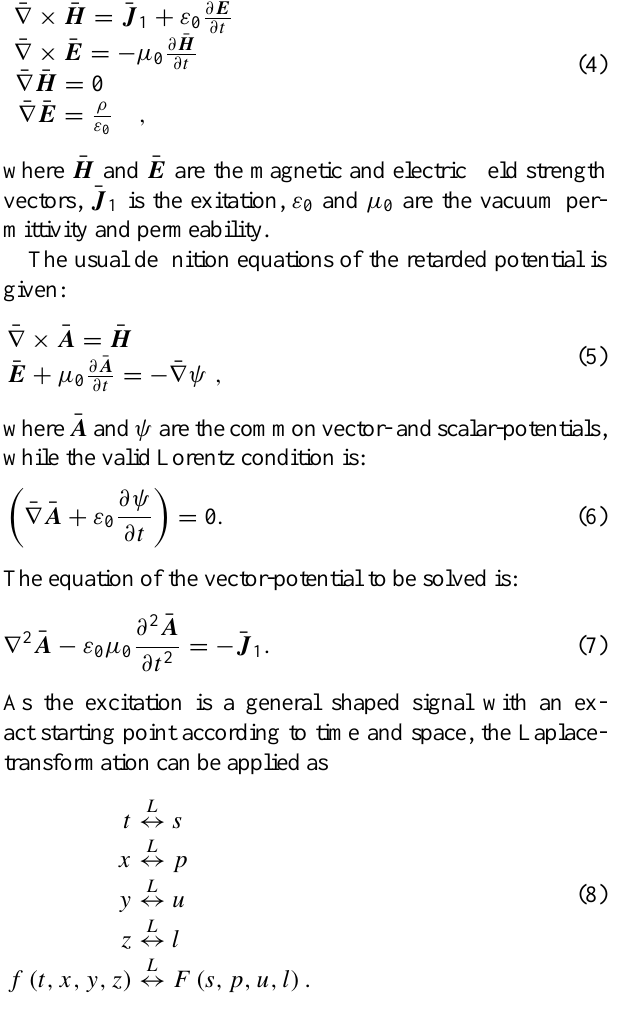
Fig. 8. Periodic extension of the source envelope